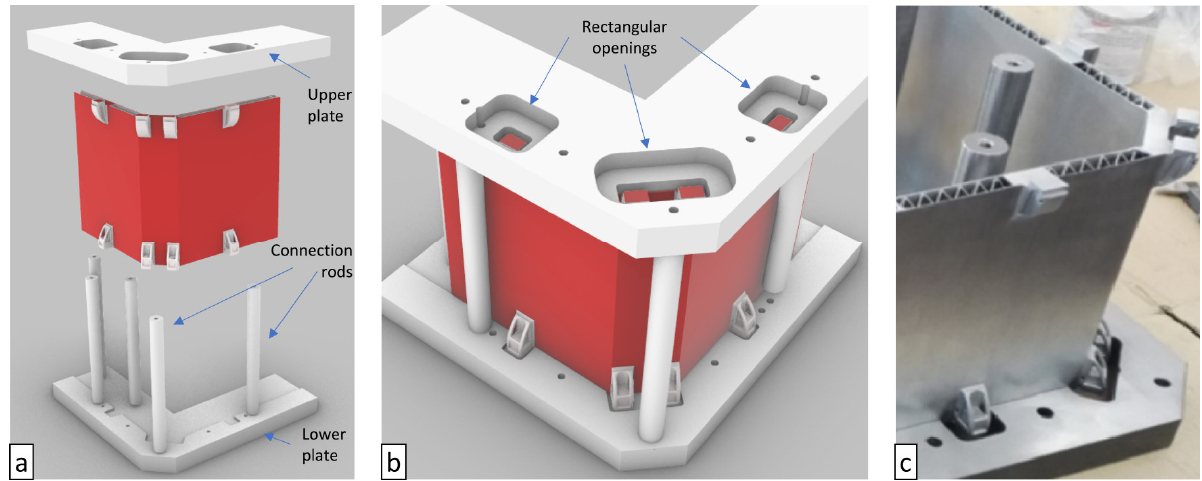
Figure 2. Exploded diagram of the assembly jig ( a ), assembled jig schematic ( b ) and real part during assembly ( c ). Surfaces to be machined are indicated in red.